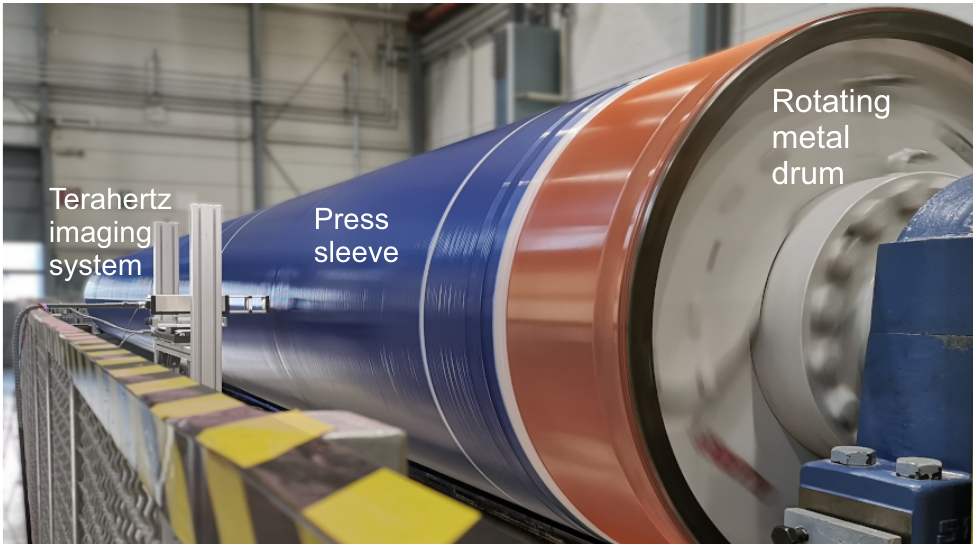
Figure 5. The terahertz imaging system setup in a realistic production environment of press sleeves for the paper industry. The sleeves are investigated within the usual production process to detect possible invisible defects at an early stage of the production line. An area of around 1 square meter of sleeve surface was recorded in this study, limited only by the total travel range of the linear translational axis. Due to the high rotational velocities of up to 150 rpm and large sleeve diameters up to 1.3 m, the terahertz FMCW transceivers are operated at very high data acquisition rates of 20 kHz to yield desired image resolutions of around 0.5